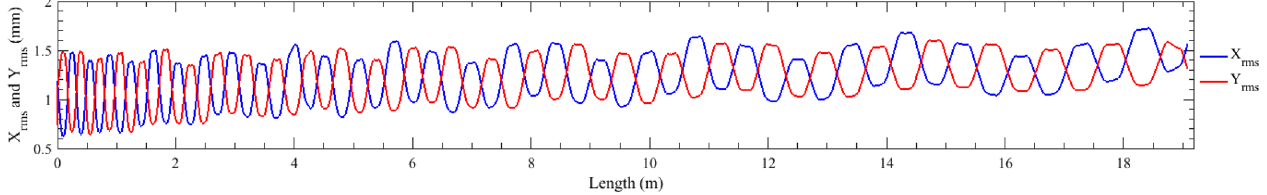
FIG. 8. Propagation of the beam envelope into the DTL for the chosen solution from the Pareto optimal NSGAII for the DTL